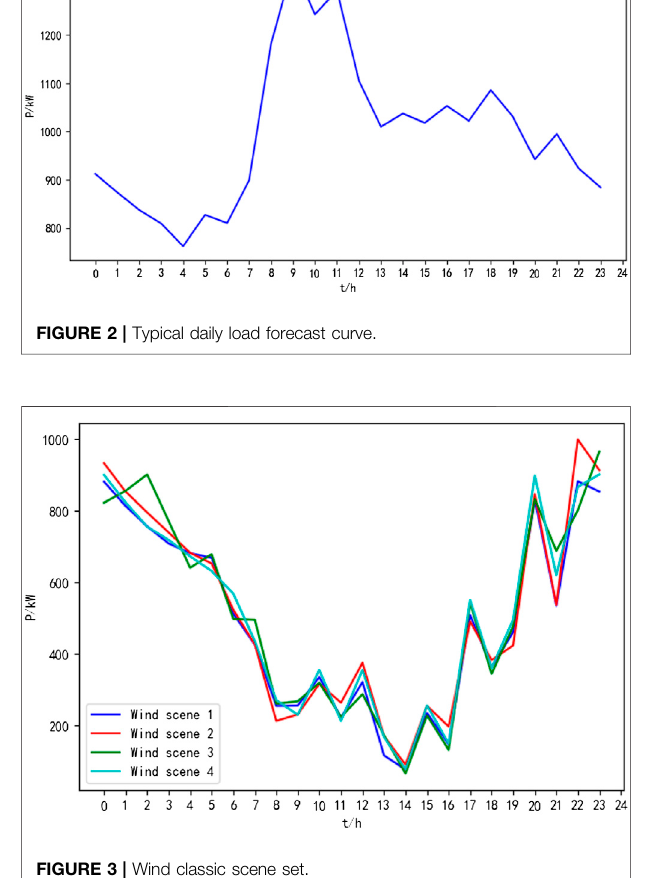
FIGURE 3 | Wind classic scene set.